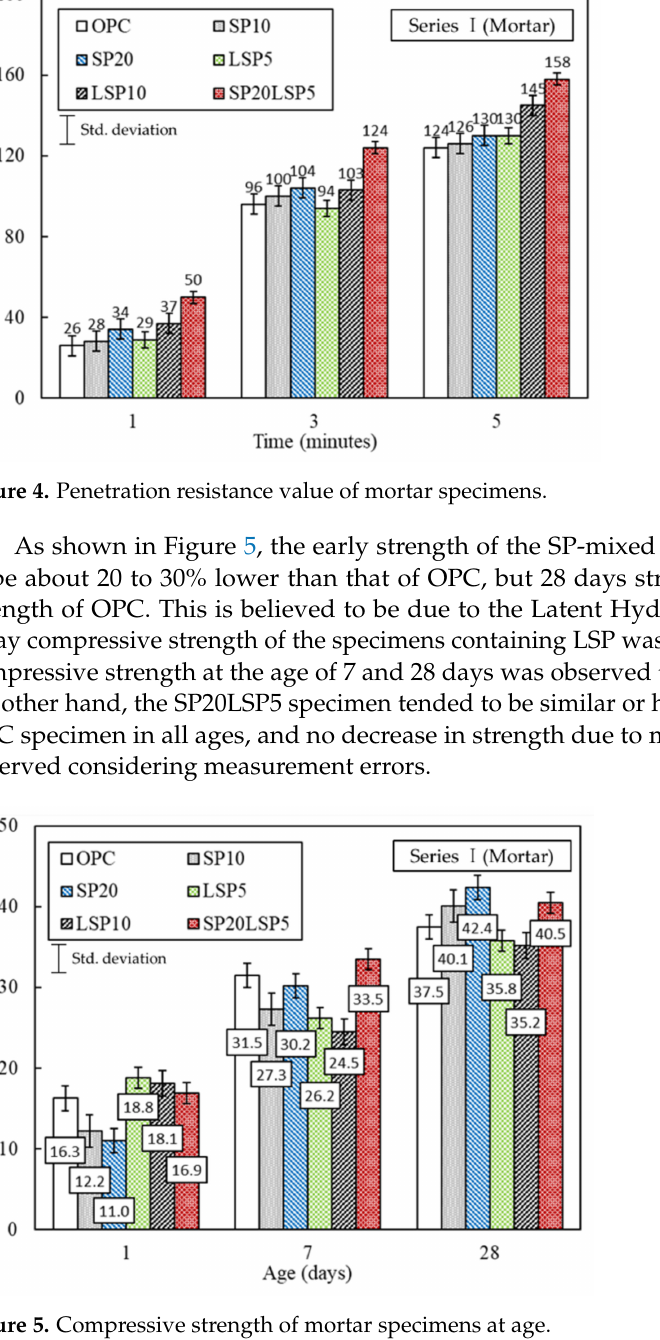
Figure 5. Compressive strength of mortar specimens at